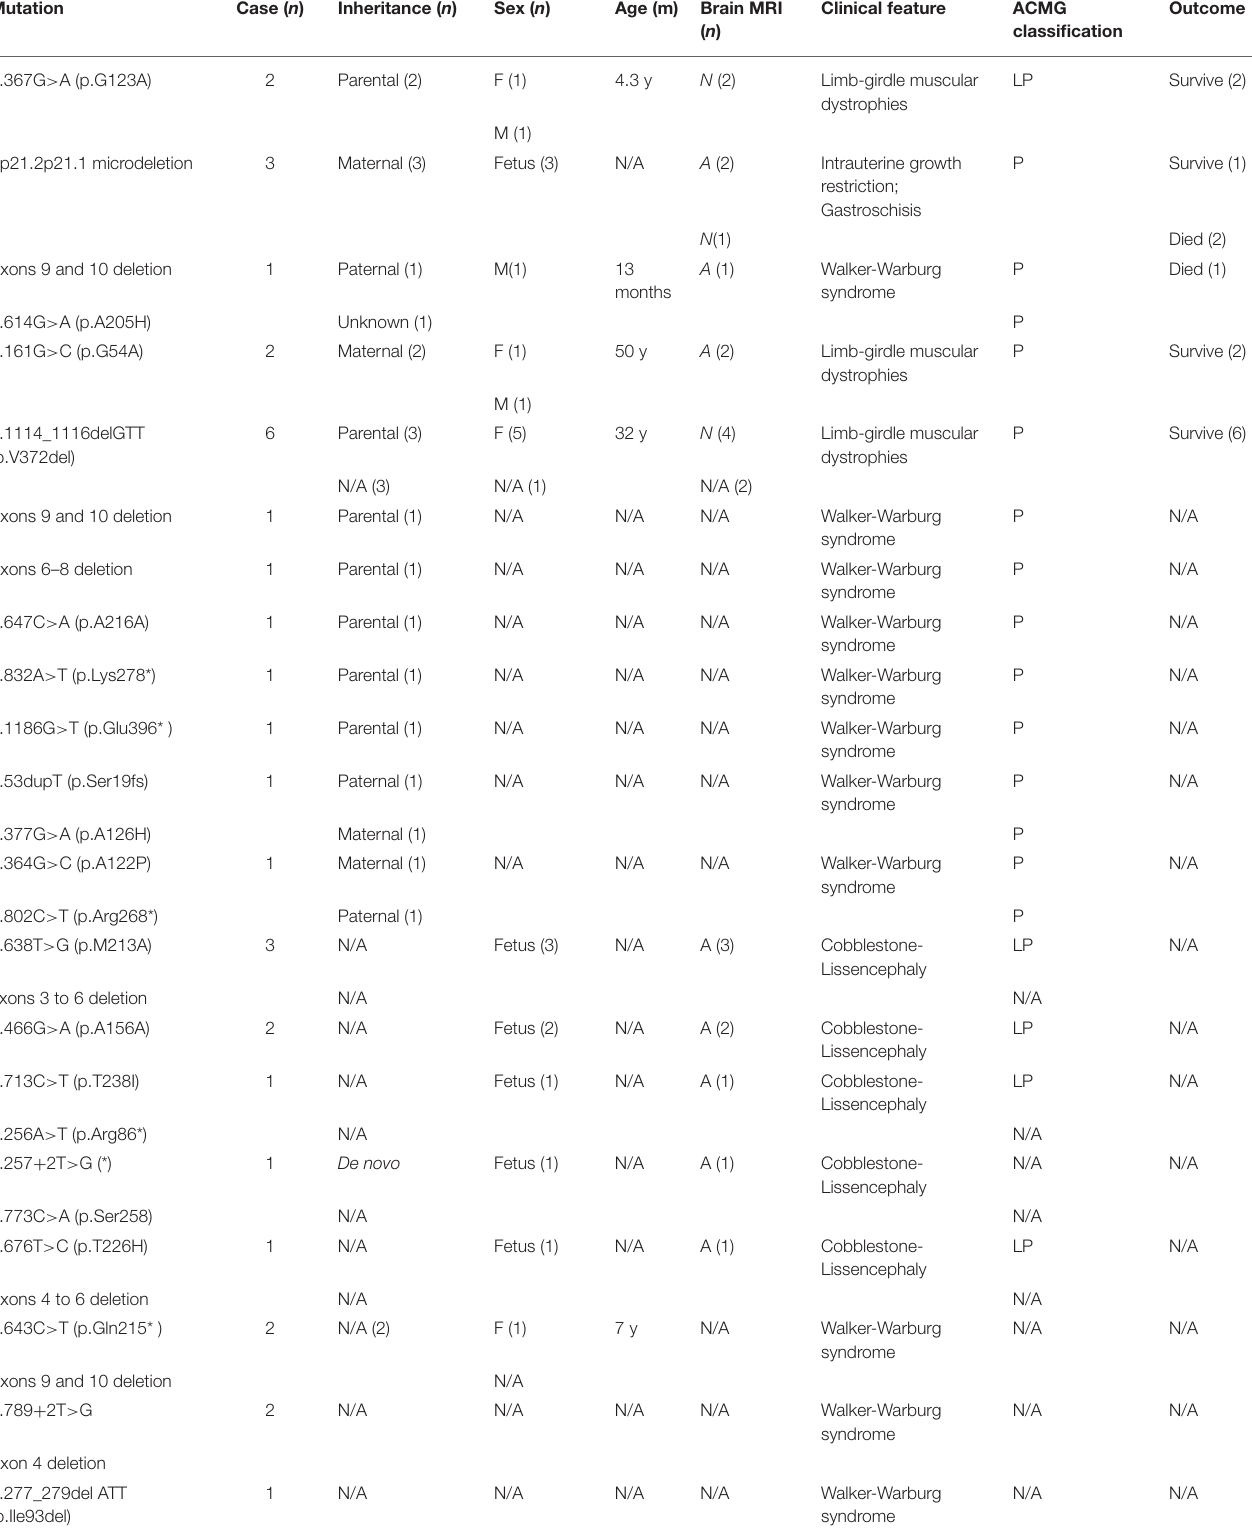
TABLE 2 | Genotype and phenotype analysis of the ISPD gene reported in literature.